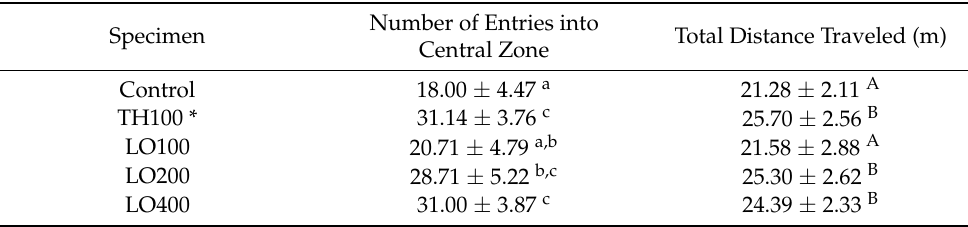
Table 3. Effect of different doses of C. osmophloeum ct. linalool leaf oil on antianxiety activity in ICR mice by the open field